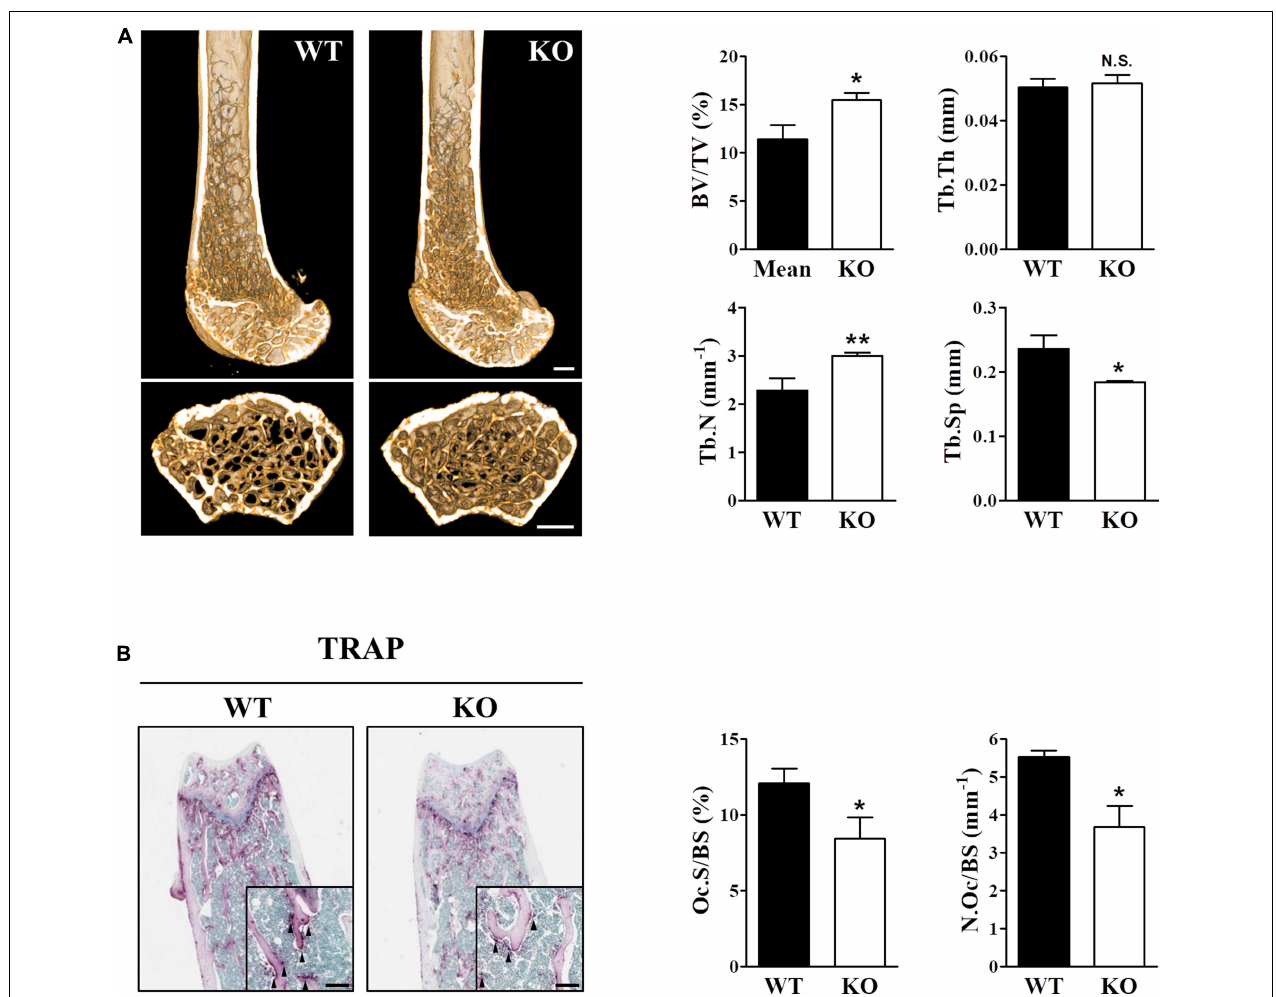
FIGURE 1 | The skeletal phenotype is altered in Sesn2 KO mice. For the in vivo experiments, distal femoral bones were isolated from WT and Sesn2 KO male mice and analyzed histologically and by micro-computed tomography ( µ CT). (A) Micro-radiographic analyses of femur obtained from 13 to 15-week old WT ( n = 6) and Sesn2 KO mice ( n = 9). The bone mass increased in Sesn2 KO mice. Bone volume over total volume (BV/TV), trabecular thickness (Tb.Th), trabecular number (Tb.N), and trabecular separation (Tb.Sp) were expressed as mean ± S.E.M. * p < 0.05 and ** p < 0.01 compared with WT mice. N.S. = not significant (Scale bar = 500 µ m). (B) Trabecular surfaces of sectioned femurs from WT ( n = 5) and Sesn2 KO mice ( n = 7) were TRAP-stained. TRAP + osteoclasts along the trabecular surfaces on bone sections are indicated by arrows. There were fewer osteoclasts on the bone surface of Sesn2 KO mice than WT mice. The percentages of TRAP-labeled osteoclast surface over bone surface (Oc.S/BS) were calculated, and the results are presented as fold-change relative to WT mice (Scale bar = 100 µ m). Oc.S/BS and number of osteoclast over bone surface (N.Oc/BS) were measured using Bio-Quant software and expressed as mean ± S.E.M. * p < 0.05 compared with